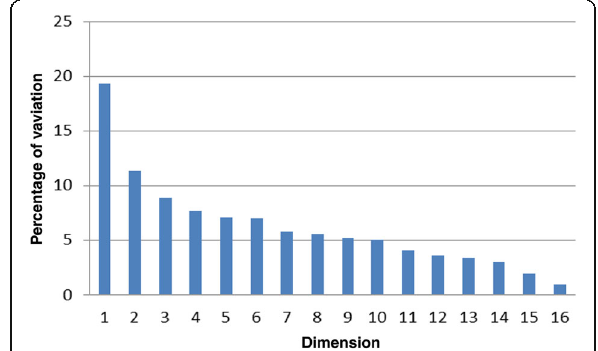
Fig. 1 Percentage of the contribution of each dimension to the total